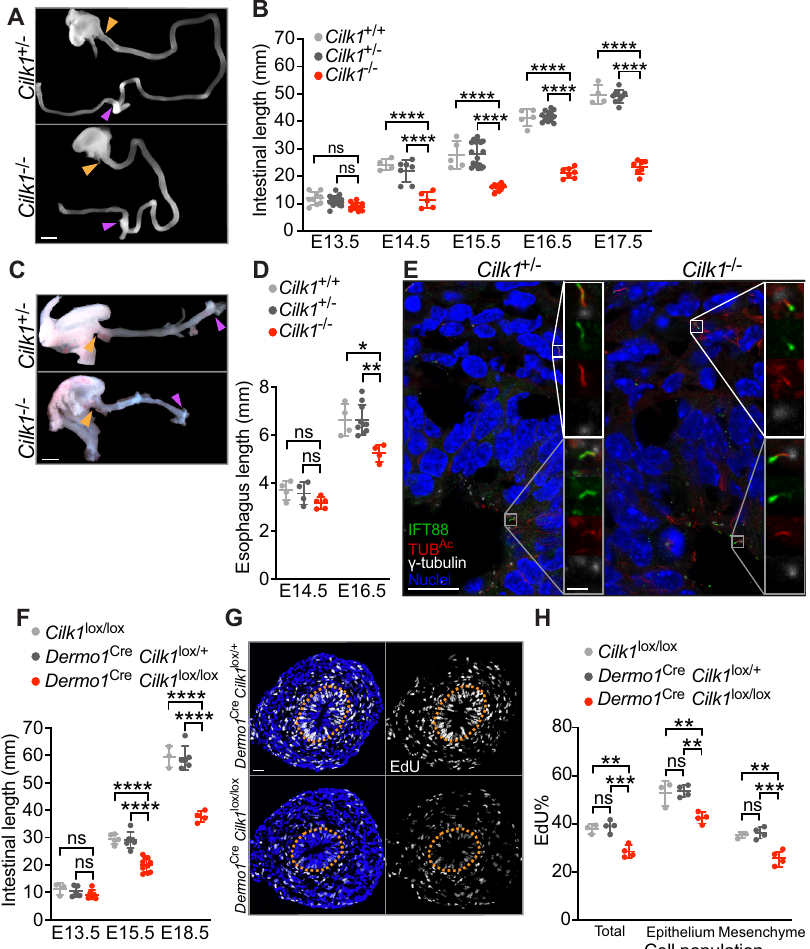
Fig. 1 Mesenchymal cilia are essential for the cell proliferation and elongation of tubular organs. A E14.5 intestines after separation from the mesentery of Cilk1 + / − and Cilk1 − / − embryos. The length of the small intestine was measured from the caudal stomach (orange arrowheads) to the rostral cecum (purple arrowheads). Scale bar, 1 mm. B Lengths of the small intestines of Cilk1 + / + ( n = 9, 4, 5, 5, 4), Cilk1 + / − ( n = 18, 7, 18, 12, 9), and Cilk1 − / − ( n = 10, 5, 9, 7, 7) embryos at E13.5, 14.5, 15.5, 16.5, and 17.5. C E16.5 esophagi of Cilk1 + / − and Cilk1 − / − embryos. The length of the esophagi was measured from the stomach (orange arrowheads) to the pharynx (purple arrowheads). Scale bar, 1 mm. D Lengths of the esophagi of Cilk1 + / + ( n = 4 and 4), Cilk1 + / − ( n = 4 and 8), and Cilk1 − / − ( n = 5 and 4) embryos at E14.5 and E16.5 (adjusted P values are 0.0021 for Cilk1 + / + vs Cilk1 − / − and 0.0003 for Cilk1 + / − vs Cilk1 − / − ). E Immuno fl uorescence staining of E13.5 intestinal cross sections from Cilk1 + / − and Cilk1 − / − embryos for IFT88 (green), ciliary axonemes (TUB Ac , red), basal bodies ( γ -tubulin, white), and nuclei (Hoechst, blue). Right, higher magni fi cations of boxed cilia. White boxes highlight mesenchymal cilia and gray boxes highlight epithelial cilia. Scale bar of larger images, 5 μ m. Scale bar of enlarged images, 2 μ m. F Lengths of E13.5, E15.5, and E18.5 control ( Cilk1 lox/lox n = 3, 5, 3 and Dermo1 Cre Cilk1 lox/ + n = 5, 7, 6) and Dermo1 Cre Cilk1 lox/lox ( n = 6, 10, 4) small intestines. G Immuno fl uorescence staining for EdU (white) and nuclei (Hoechst, blue) in E13.5 Dermo1 Cre Cilk1 lox/ + and Dermo1 Cre Cilk1 lox/lox intestines. Scale bar, 25 μ m. Orange dotted lines outline the epithelium. H The percentage of EdU-positive cells in the whole intestine, the epithelial cells and the mesenchymal cells in Cilk1 lox/lox ( n = 3), Dermo1 Cre Cilk1 lox/ + ( n = 4) and Dermo1 Cre Cilk1 lox/lox ( n = 4) embryos at E13.5. For each intestine, we averaged the percentages from three sections. B , D , F , and H Each point in the scatter plots represents the value from an individual embryonic intestine or esophagus. Horizontal bars indicate means ± SD. ns, p > 0.05; * p < 0.05; ** p < 0.01; *** p < 0.001 and **** p < 0.0001 indicate adjusted P values between indicated samples by two-way ANOVA Tukey ’ s multiple comparisons test. Source data are provided in the Source Data fi